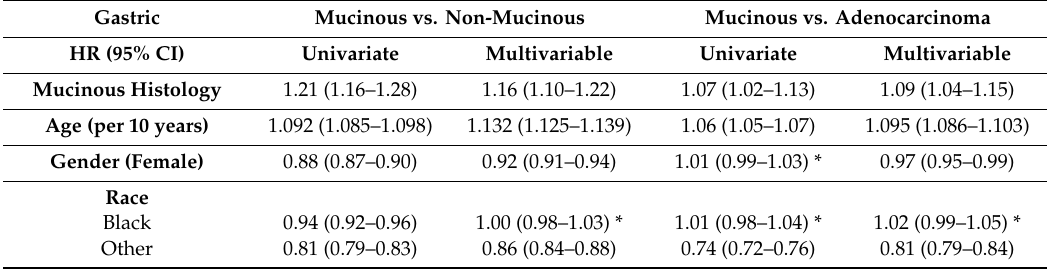
Table 12. Derived univariate and multivariable Cox-proportional hazard ratios (HR) of mortality for gastric